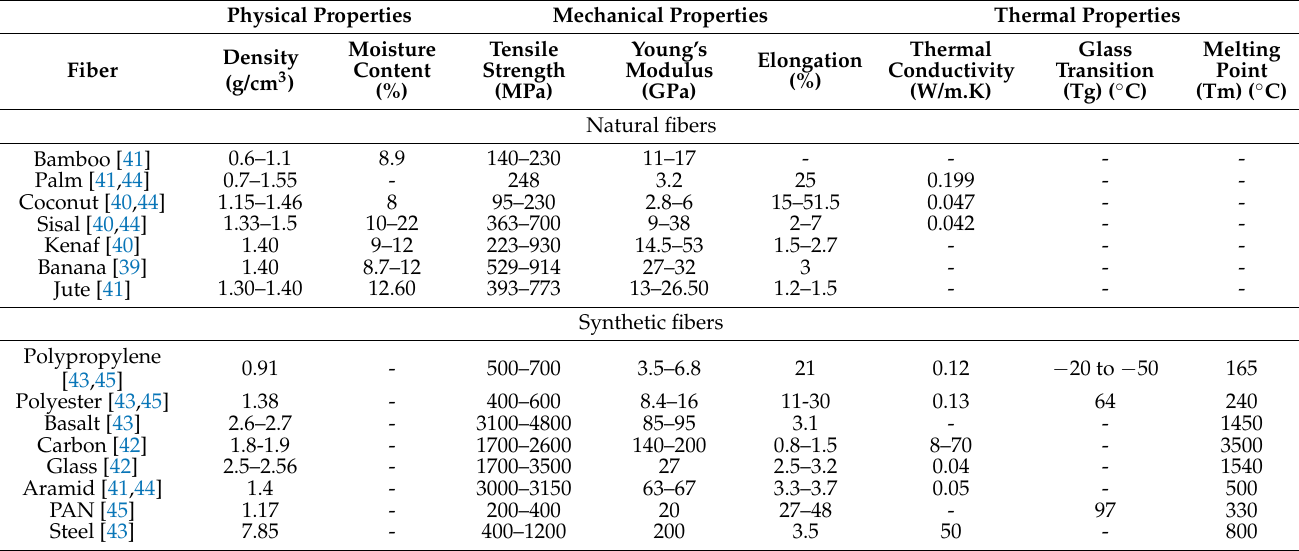
Table 1. Physical, mechanical, and thermal properties of fibers [39–45].